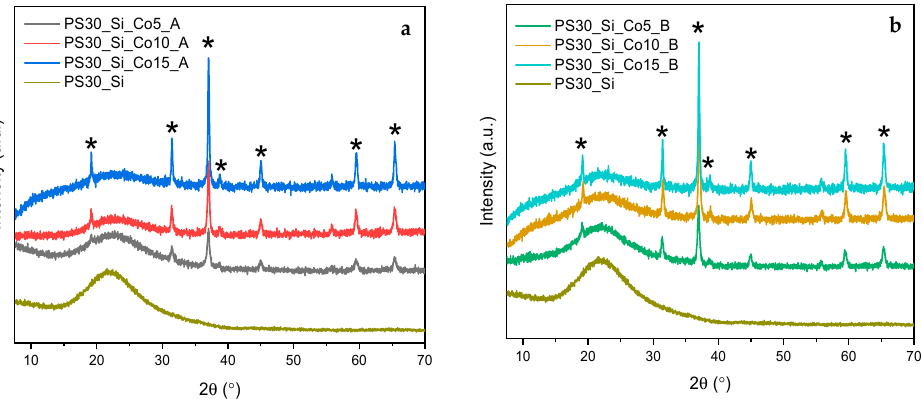
Figure 4. XRD patterns of PS30_Si-based catalysts synthesized in the path A ( a ) and B ( b ). Reflections characteristic for the Co 3 O 4 phase are marked with an asterisk.